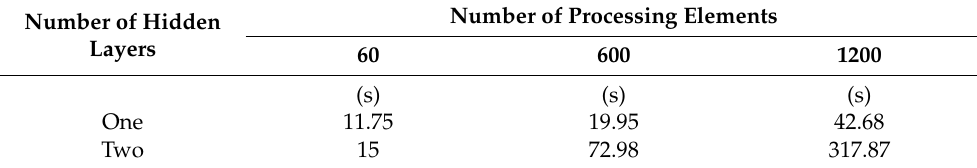
Table 5. The run time (s) of the proposed model for different numbers of hidden layers and processing